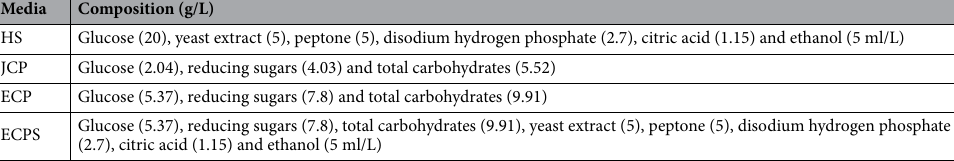
hydrolysis was monitored by measuring the total carbohydrate, glucose, and reducing sugars liberated during the hydrolysis course. Total carbohydrates were evaluated by the anthrone-sulfuric acid method according to Ludwig et al. 132 , glucose concentration was determined using a glucose assay kit (Oxidase), and reducing sugars released were determined with the dinitrosalicylic acid (DNS) method 133 . The enzymatic hydrolysis rate of CP was calculated 134 according to the following equation: